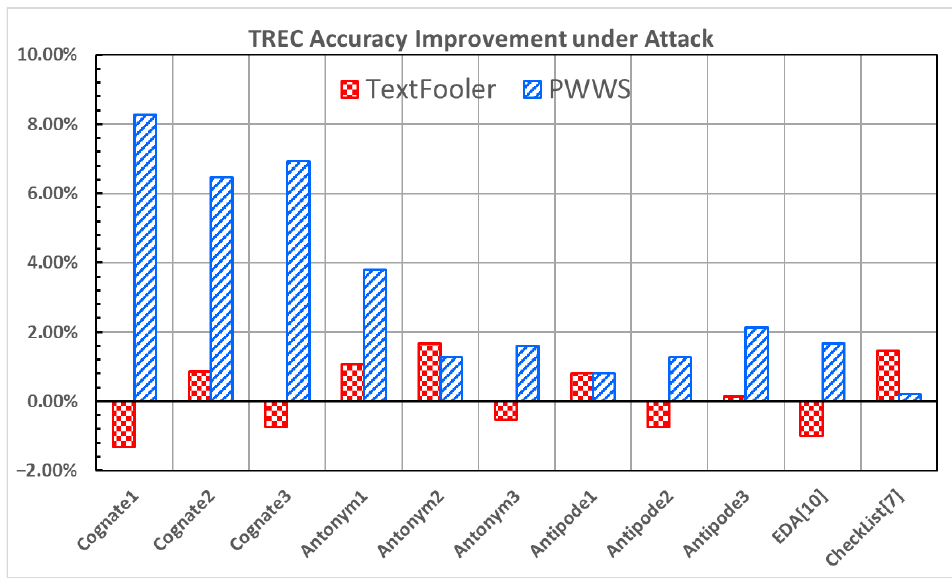
Figure 7. TREC Accuracy Improvement Under Attack.